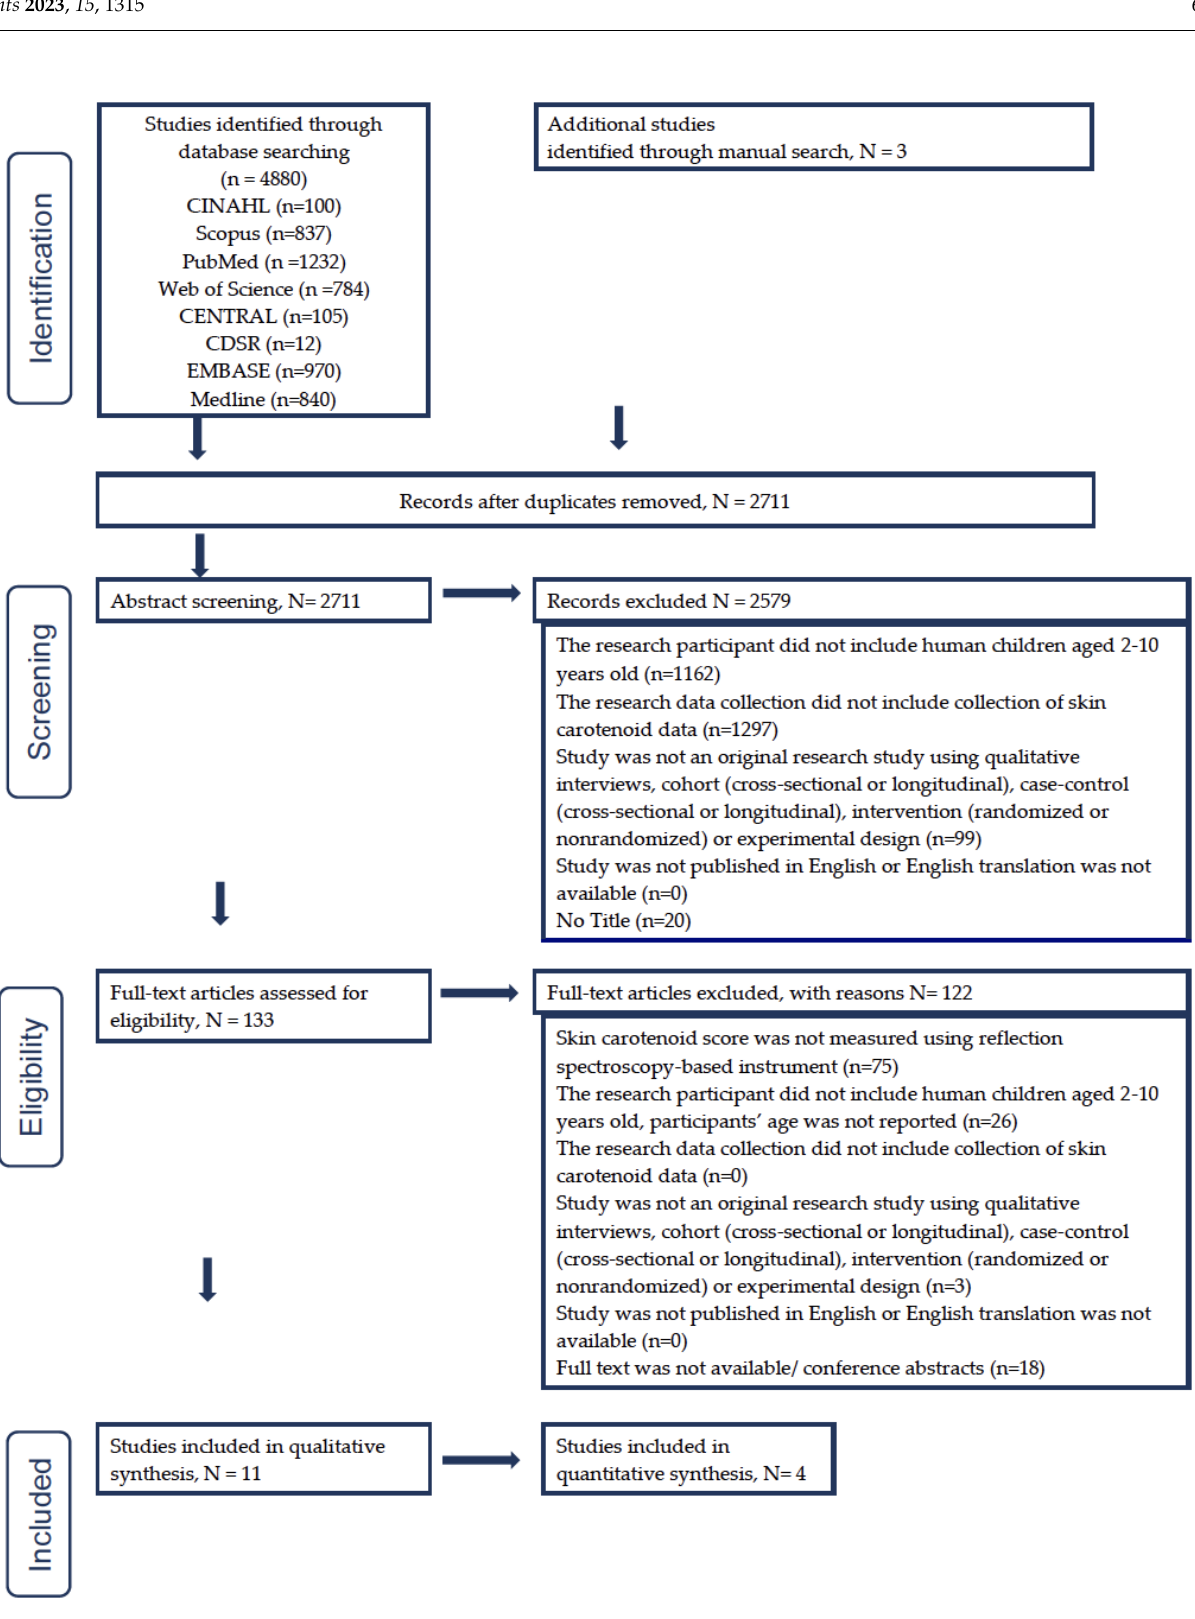
Figure 2. Study selection flowchart based on PRISMA (Preferred Reporting Items for Systematic Reviews and Meta-Analyses) statement guidelines [43].